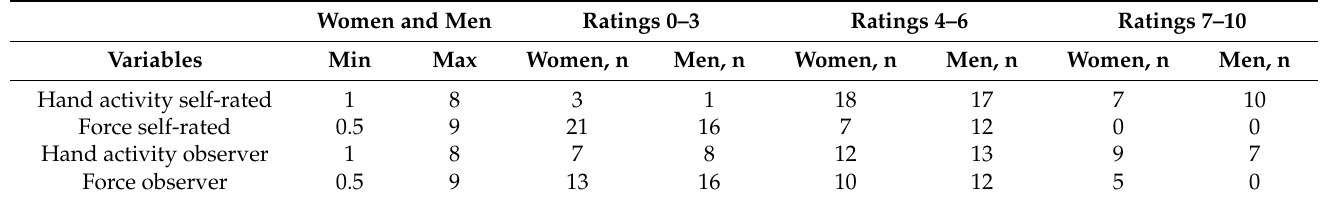
Table 4. Self- and observer-rated hand activity and force in women and men in the 18 work tasks with numbers (n) of women and men represented in three levels (0–3, 4–6 and 7–10) of hand activity and force.